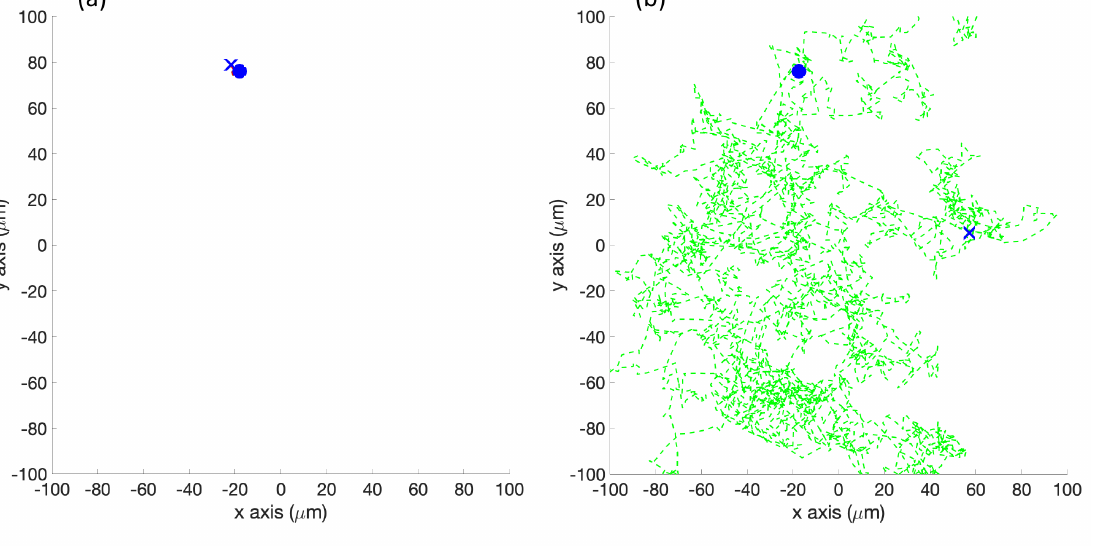
Figure 10. Case 1: Without obstacles, in the homogeneous/no effluent environment, typical trajectories of the simulated robot running ( a ) the basic chemotaxis controller, and ( b ) the RapidCell chemotaxis controller. In each trajectory, the initial position is shown as a blue circle and the terminal position is shown as a blue “X”. Positions corresponding to concentrations less than 1m M are shown in dashed green, otherwise shown in red. The detected concentration was zero in both controllers for this